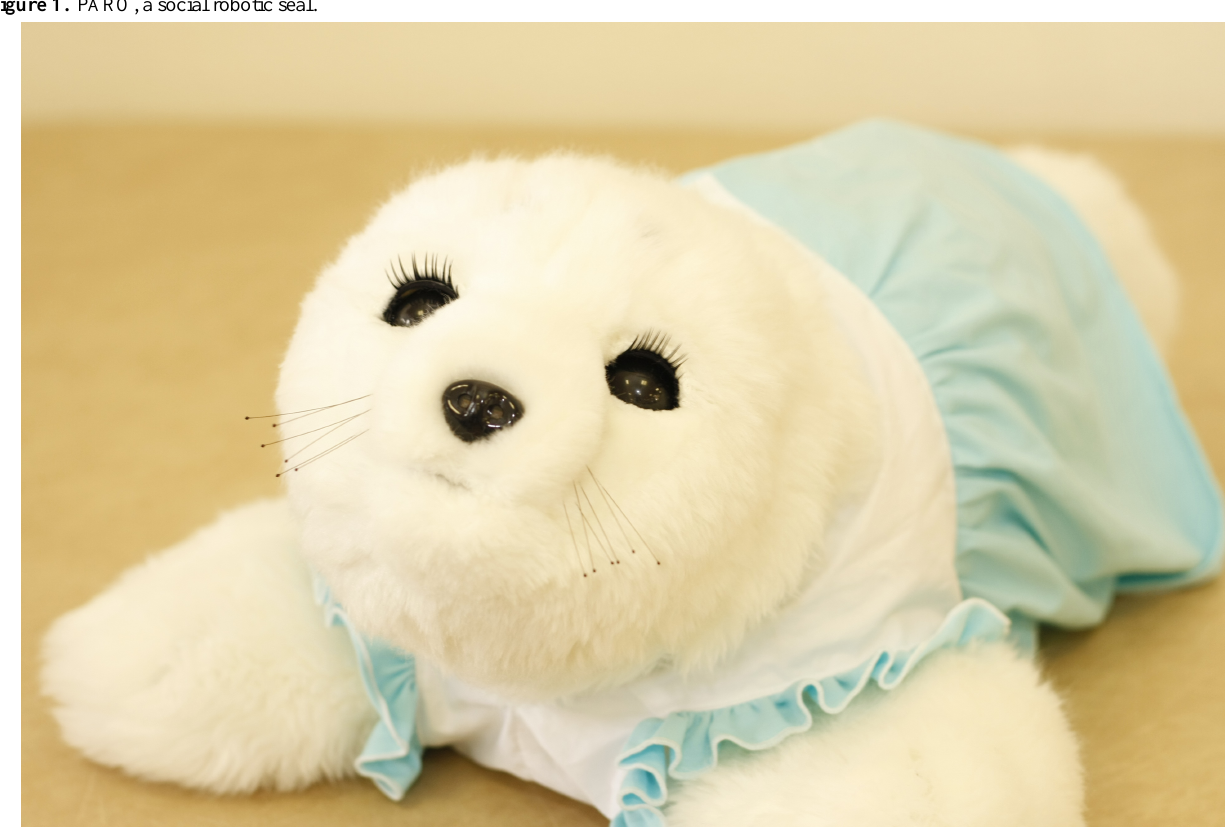
Figure 1. PARO, a social robotic